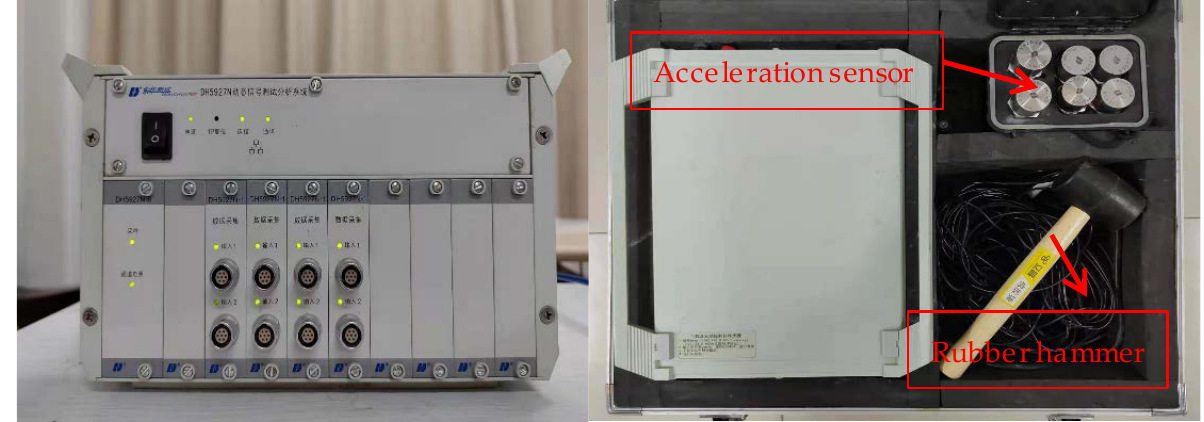
Figure 6. Dynamic signal analysis system and components.